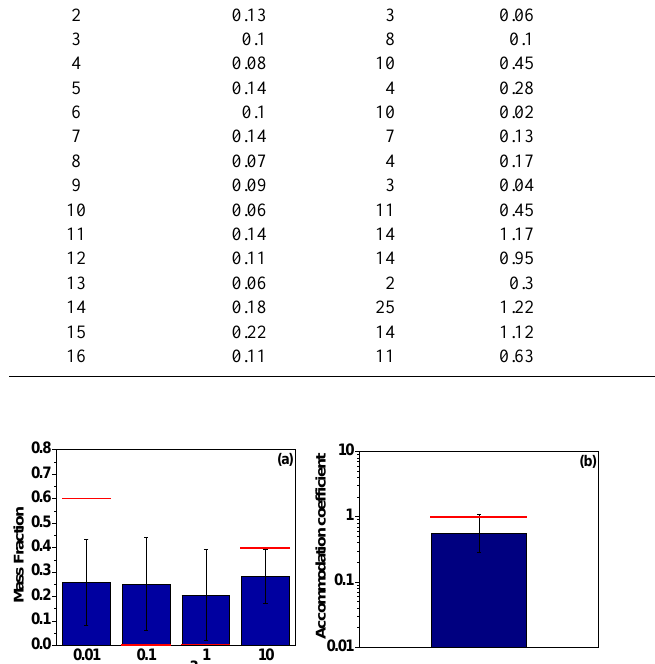
0.01 Figure 7. Estimated (bars) volatility distribution and accommoda- tion coefficient and true (red lines) values using isothermal dilu- Figure 7. Estimated (bars) volatility distribution and accommodation coefficient and true (red tion “measurements”, for an OA with 60% 0.01µgm − 3 and 40% lines) values using isothermal dilution “measurements”, for an OA with 60% 0.01 μg m -3 and 10µgm − 3 ; 1H vap = 100kJmol − 1 and a m = 1. (a) Volatility dis- 40% 10 μg m -3 , ΔH vap =100 kJ mol -1 and a m =1. (a) volatility distribution and (b) a m . tribution and (b) a m